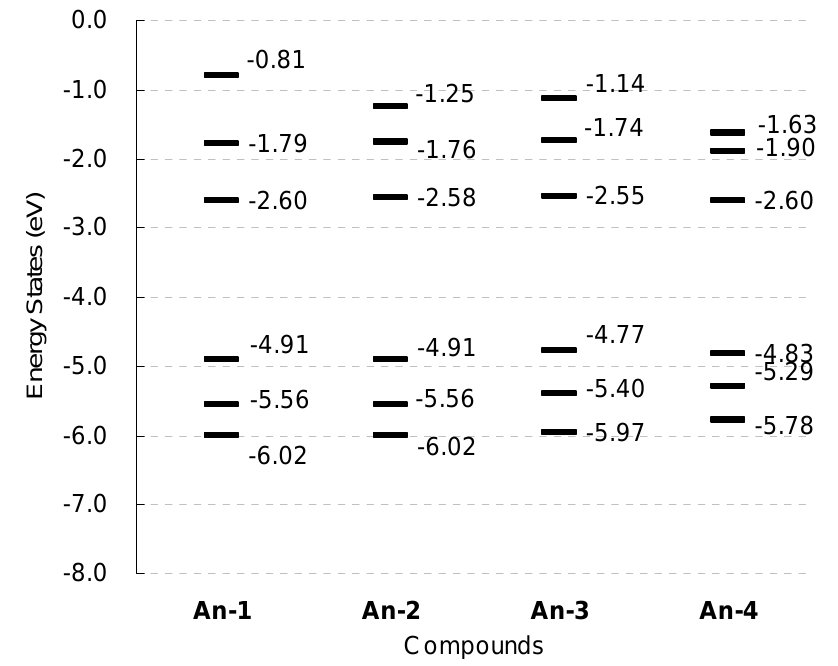
Figure 10. Schematic representation of the calculated electronic structure in the gas-phase for the